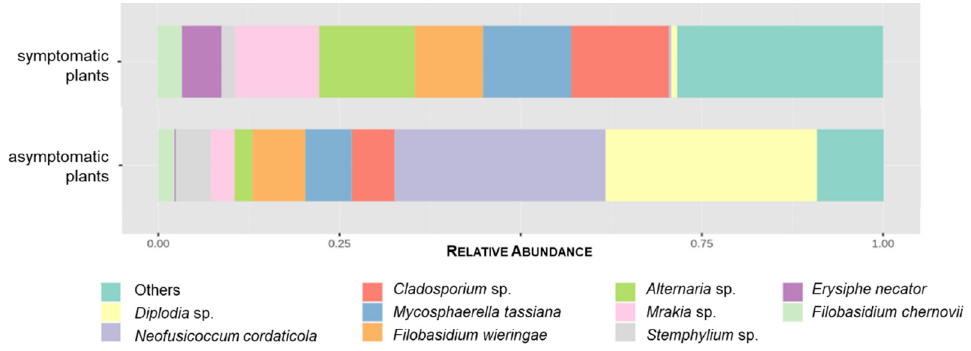
Figure 3. Relative abundance of the top 10 fungal species according to the presence or absence of GTDs symptoms, considering the 215 OTUs assigned to genus or species level. Remaining OTUs are grouped in “Others”.